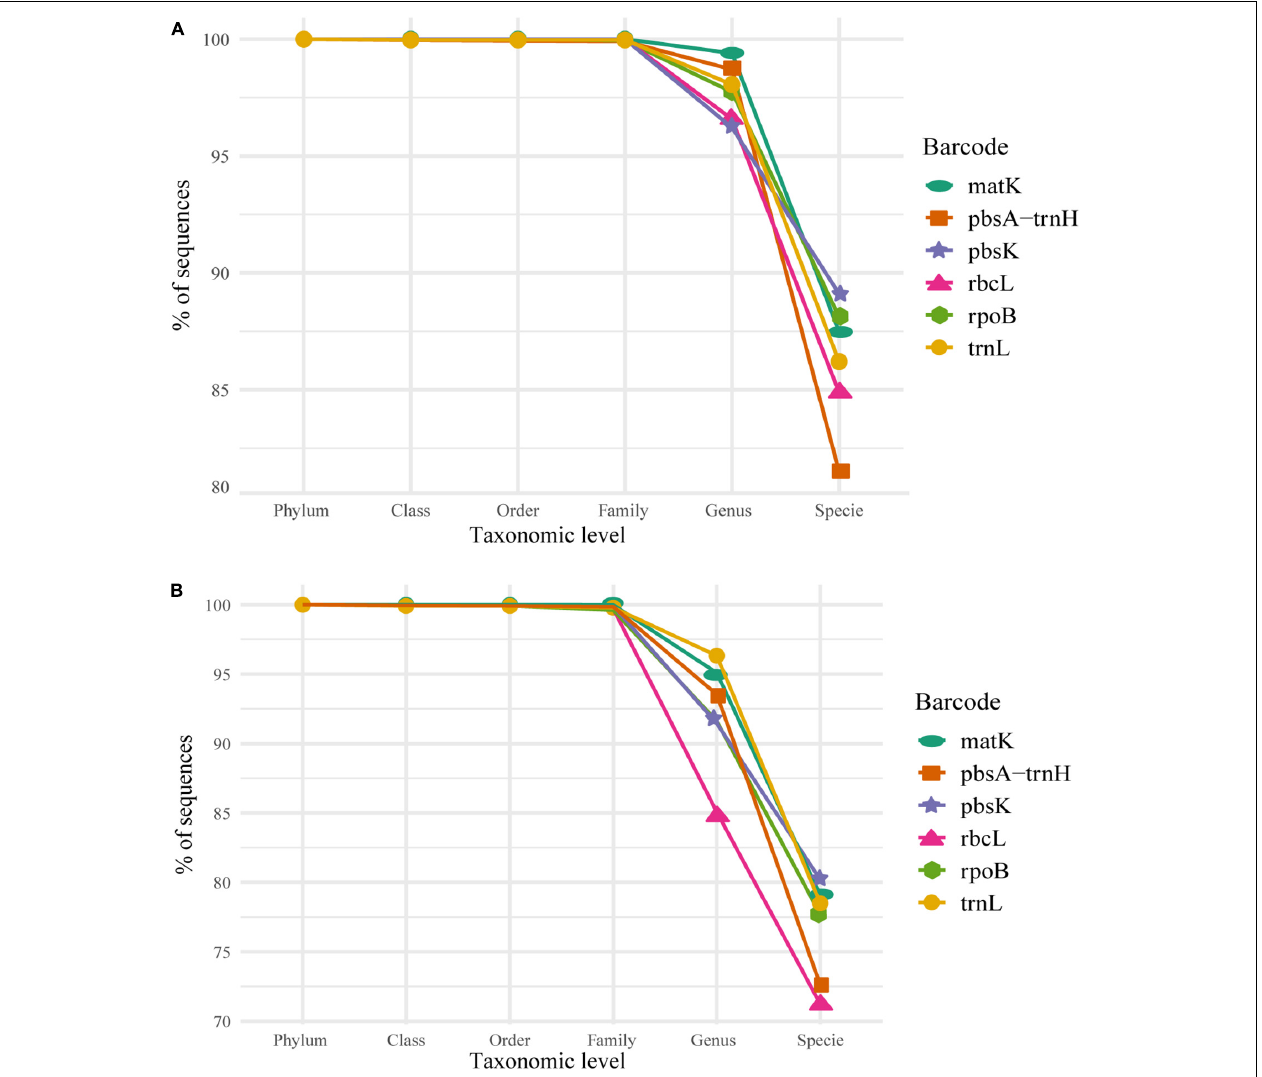
FIGURE 2 | Individual marker performance, as percentage of correctly classified sequences, of the Naïve Bayesian Classifiers (NBC) from Phylum to Species based on the selected bootstrap criterion (80%) in (A) the 5–20 dataset and (B) the 2–20 dataset. Consider that the scale for the y -axis in both plots varies, 80–100% for panel (A) and 70–100% for panel (B) , for visualization